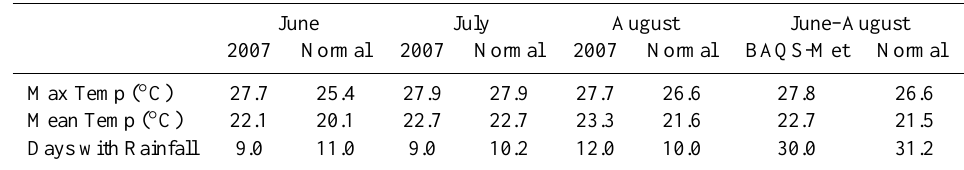
Table 3. Climatological averages for June, Jul and August 2007 compared to climatological normals. Data are from Environment Canada’s historical weather web portal found at